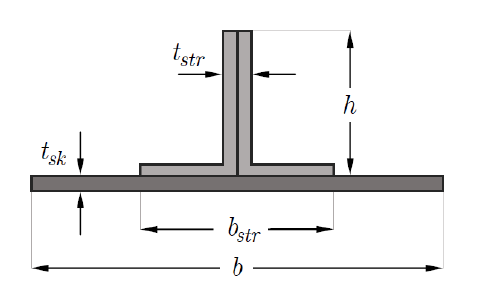
Figure 4. Cross-section of the blade-type stiffened panel representative